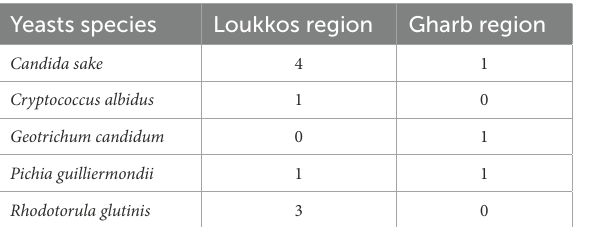
TABLE 7 Prevalence of yeast strains contaminating strawberry fruits from the two localities Loukkos and Gharb. Yeasts